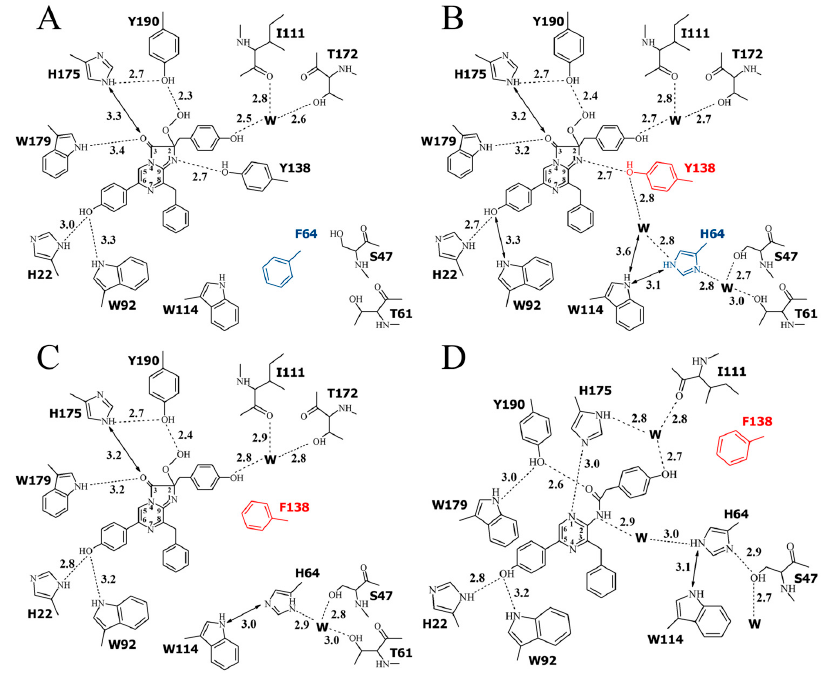
Figure 5. Two-dimensional representation of the hydrogen bond network. ( A ) OL_H64F mutant (PDB 8C6O, chain A), ( B ) wild-type obelin (PDB 1QV0), ( C ) active OL_Y138F mutant (PDB: 4MRX), and ( D ) Ca 2+ -discharged OL_Y138F mutant (PDB 4MRY). Mutated residues H64(F64) and Y138(F138) are shown in blue and red, respectively. Hydrogen bonds are shown as dashed lines, distances between atoms are shown as arrows, and “W” stands for a water molecule. Distances are given in Å.